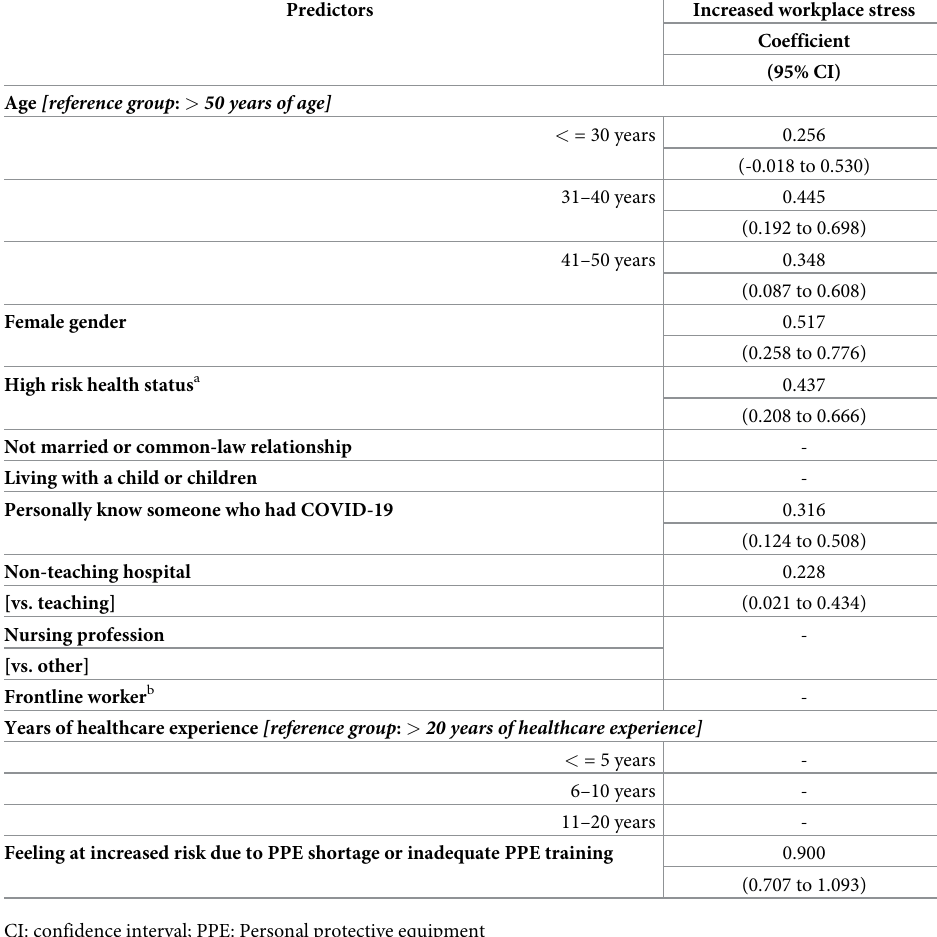
Table 2. Multivariable analysis of the predictors of increased workplace stress among hospital workers during the COVID-19 pandemic.